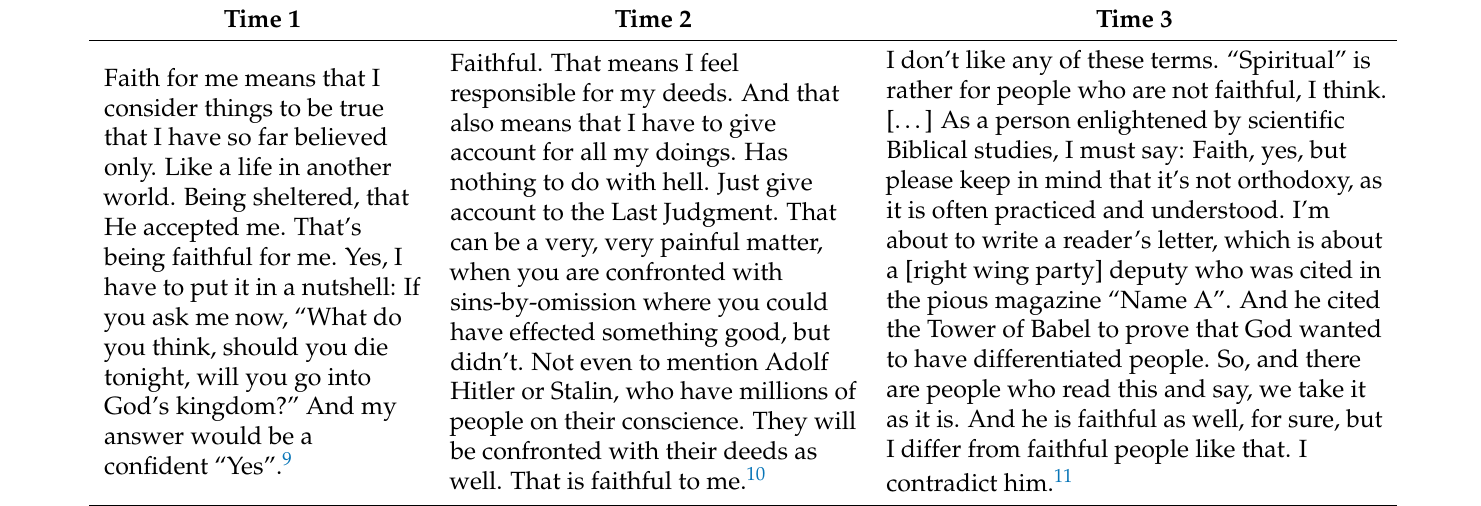
Table 2. Werner’s answers to Question 20: “Do you consider yourself a religious, spiritual, or faithful